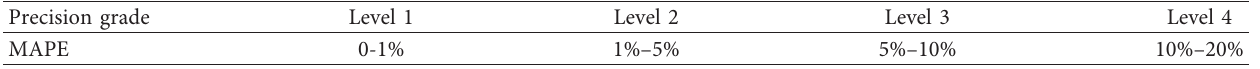
Table 3: Table of accuracy levels for MAPE values.